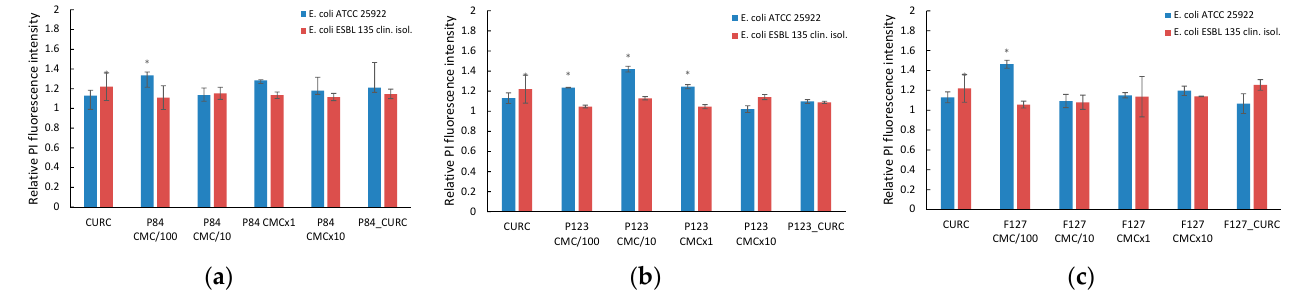
Figure 7. Relative PI fluorescence in E. coli cultures incubated with micellar and unassociated molecules of Pluronic derivatives: Pluronic P84 ( a ); Pluronic P123 ( b ); Pluronic F127 ( c ). The concentration of Curcumin solubilized in DMSO and in polymeric micellar dispersion is 100 μ M. Concentrations of Pluronic derivatives were selected according to their CMC values (Table 1) to cover the micellar domain (concentrations equal to CMC and 10-fold higher) and unimer domain (concentrations equal to CMC/100 and CMC/10).